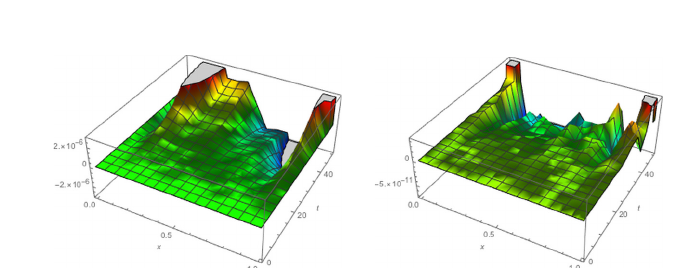
Figure 2. The absolute errors for ν = 1 . 5 and β = 1 with M = 7 ,N = 2 (left) and M = 10 ,N = 2 (right) on the interval [0 , 1] × [0 , 50] of Example 3.